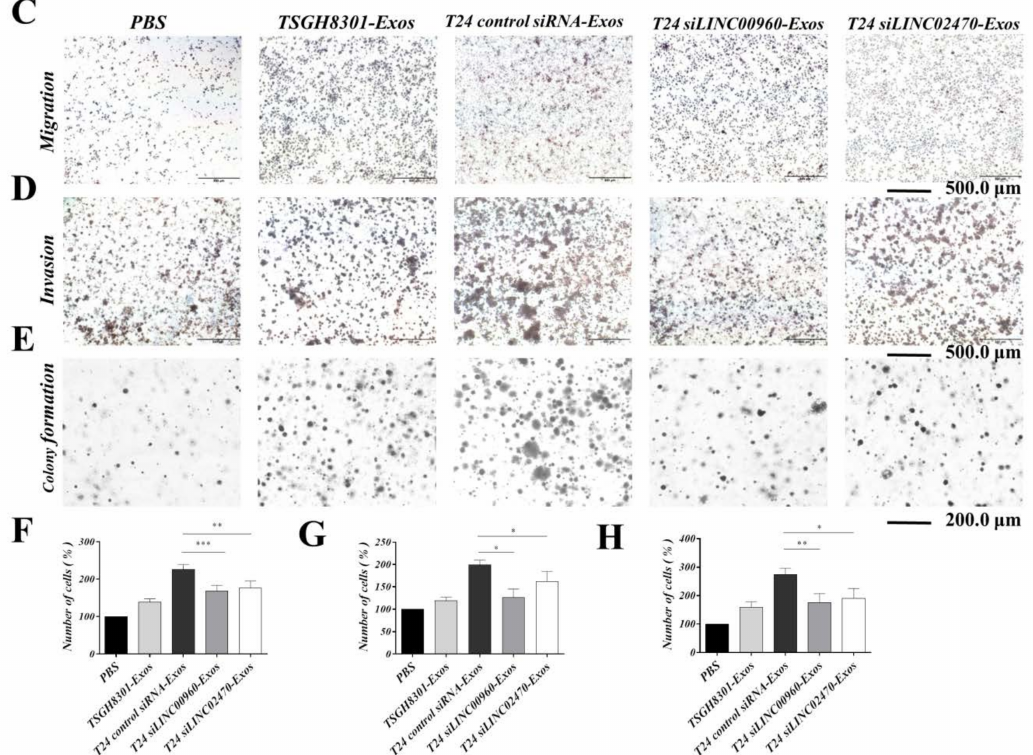
Figure 7. Exosomes derived from LINC00960-knockdown or LINC02470-knockdown T24 cell conferred less aggressiveness-inductive abilities in recipient TSGH-8301 cells. T24 siLINC00960-Exos or T24 siLINC02470-Exos induced less migratory ability ( A , B for wound healing assay and C , F for transwell assay), invasive ability ( D , G for Matrigel-coated transwell assay), and clonogenicity ( E , H for soft-agar colony formation assay) of recipient TSGH-8301 cell when compared to T24-Exos. All experiments were performed with the identical time-points shown in Figure 3, and the bar-charts showed the mean and SD of triplicate experiments, * p < 0.05, ** p < 0.01, *** p <